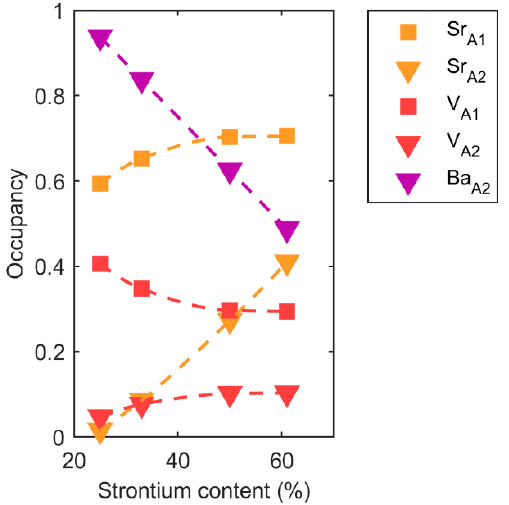
Figure 5. Occupancy of Sr, Ba, and vacancy on the A1 and A2 sites for the SBN ceramics heat treated at 800 °C.